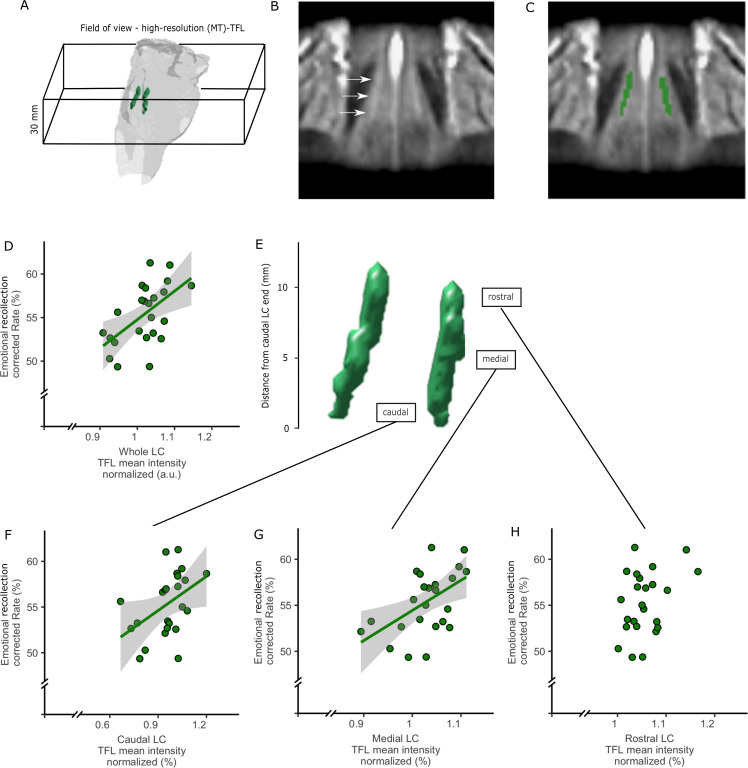
Structural segmentation of the LC and associations with emotional memory performance (N = 24).(A) 3D visualization of the LC placement in the pons. (B) The LC template, coronal view (hyperintense rod-like shape). (C) Segmentation of the LC in template (green). (D) TFL mean intensity normalized with a pontine reference region of the entire LC correlated with emotional memory recollection rate (r = 0.562; p-value=0.004) E) The LC was divided into three equisized subsegments. (F–H) LC segments intensity correlation with emotional memory recollection rate: (F) caudal (r = 0.523; p-value=0.034) (G) medial (r = 0.523; p-value=0.009) and (H) LC rostral (r = 0.523; p-value=0.074). Shaded regions depict the 95% confidence interval.Figure 8—source data 1.Structural locus coeruleus intensity and memory performance.Individual locus coeruleus intensity values (entire locus coeruleus, rostral, middle and caudal) and emotional memory scores are provided. The emotional memory scores are calculated as the proportion of adjusted emotional scores versus neutral scores as indicated in the methods.